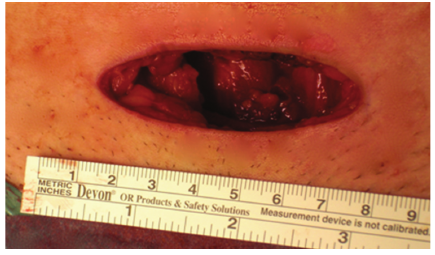
Figure 1: minilaparotomy (7cm).